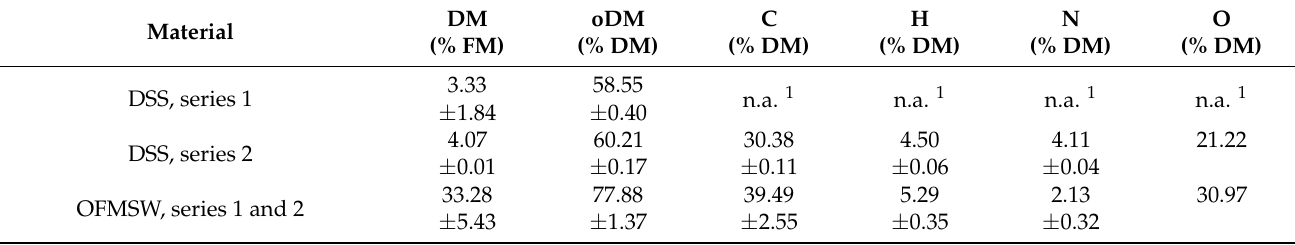
Table 3. Dry matter content (DM), organic dry matter content (oDM), chemical elements of digested sewage sludge (DSS) used as inoculum, and organic fraction of municipal solid waste (OFMSW) used as substrate; mean values ± standard deviation.